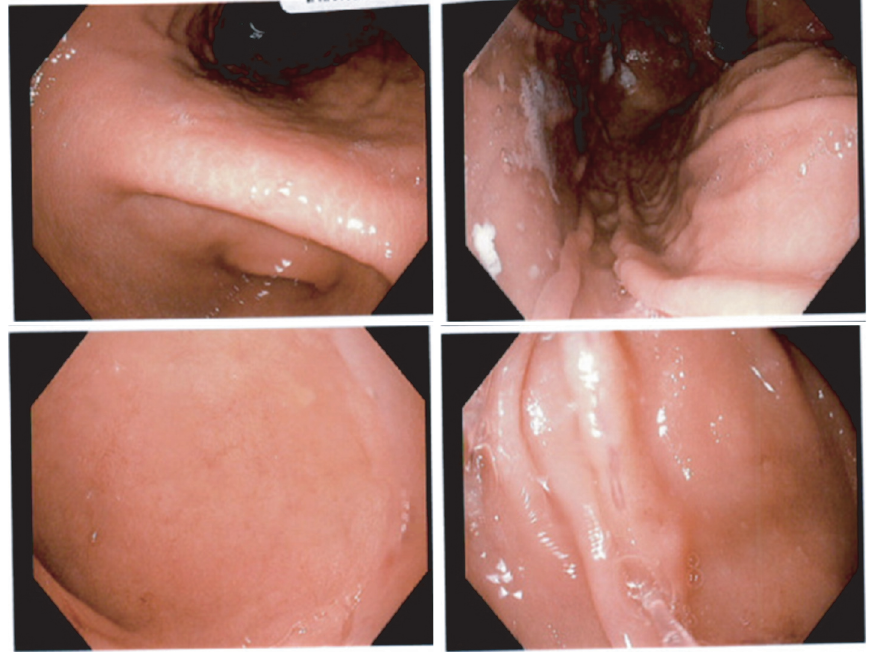
Figure 2: Endoscopic appearance of